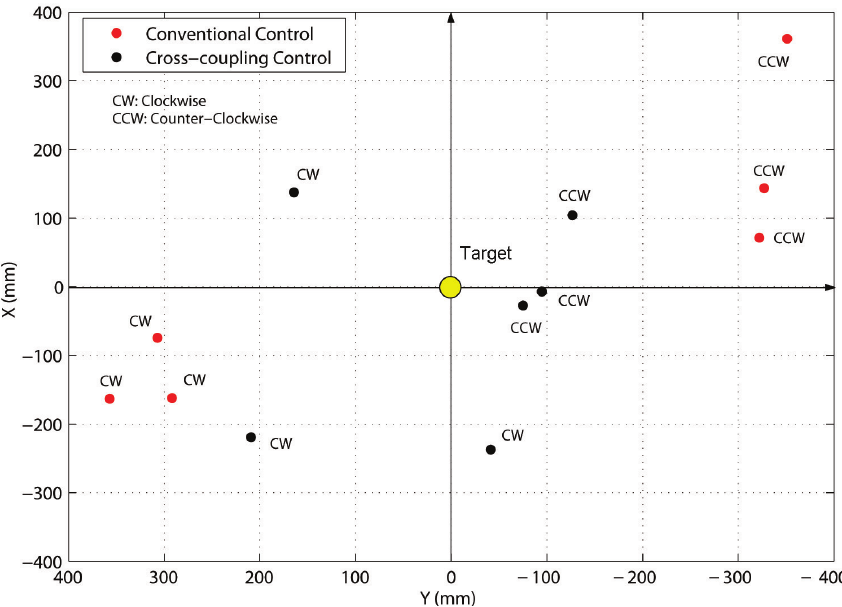
Figure 12. Return position errors for the closed-loop experiments. Black dot: Cross-coupled control. Red dot: Conventional